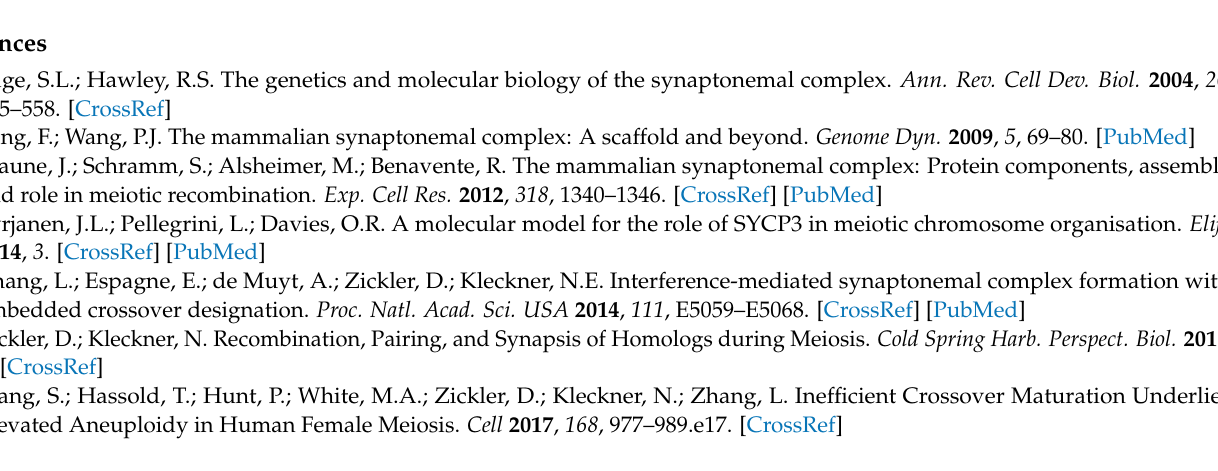
Figure S4. Spread chicken oocytes immunostained for SCs and MLH1, Figure S5. Additional typical pachytene nuclei used for MLH1 focus counts, Figure S6. GC content plot of GGA1 1-80, Figure S7. Chromosome size and CO rates are inversely related, Table S1. Positions of the BAC clones expressed in bp from the sequence start of the assembly of GGA1, Table S2. DNA density in the intervals limited by the BAC clone positions on the SC, Table S3. Average number of foci in macro- and